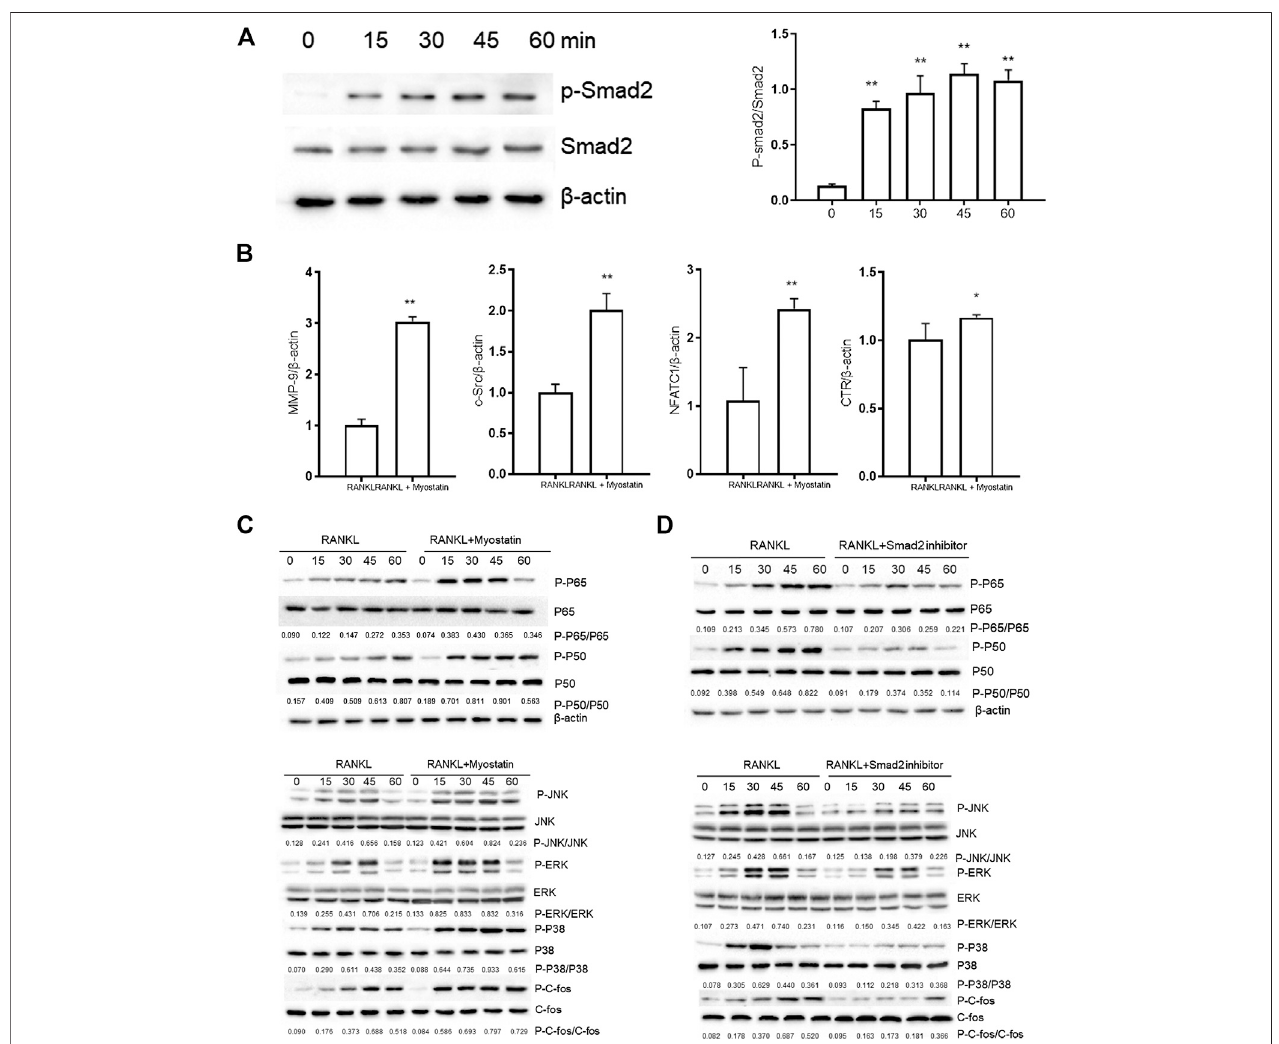
FIGURE 3 | Myostatin promotes the differentiation of osteoclasts by activating Smad2 and activates NF- κ B and MAPK pathways. (A) P-Smad2 and Smad2 were detected by western blot. (B) Total RNA from RAW264.7 cells treated with or without myostatin for 24 h was analyzed by RT-PCR to detect the expressions of CTR, C-SRC, MMP-9, and NFATc1. (C) The expressions of P-p65/p65, P-p50/p50, P-JNK/JNK, P-ERK/ERK, P-p38/p38, and P-c-fos/c-fos were analyzed by western blotting. (D) RAW264.7 cells were cultured with RANKL and M-CSF in the presence or absence of LY209761 and collected at 0, 15, 30, 45, and 60 min. The expressions of P-p65/p65, P-p50/p50, P-JNK/JNK, P-ERK/ERK, P-p38/p38, and P-c-fos/c-fos were analyzed by western blot. * p < 0.05, ** p < 0.01.